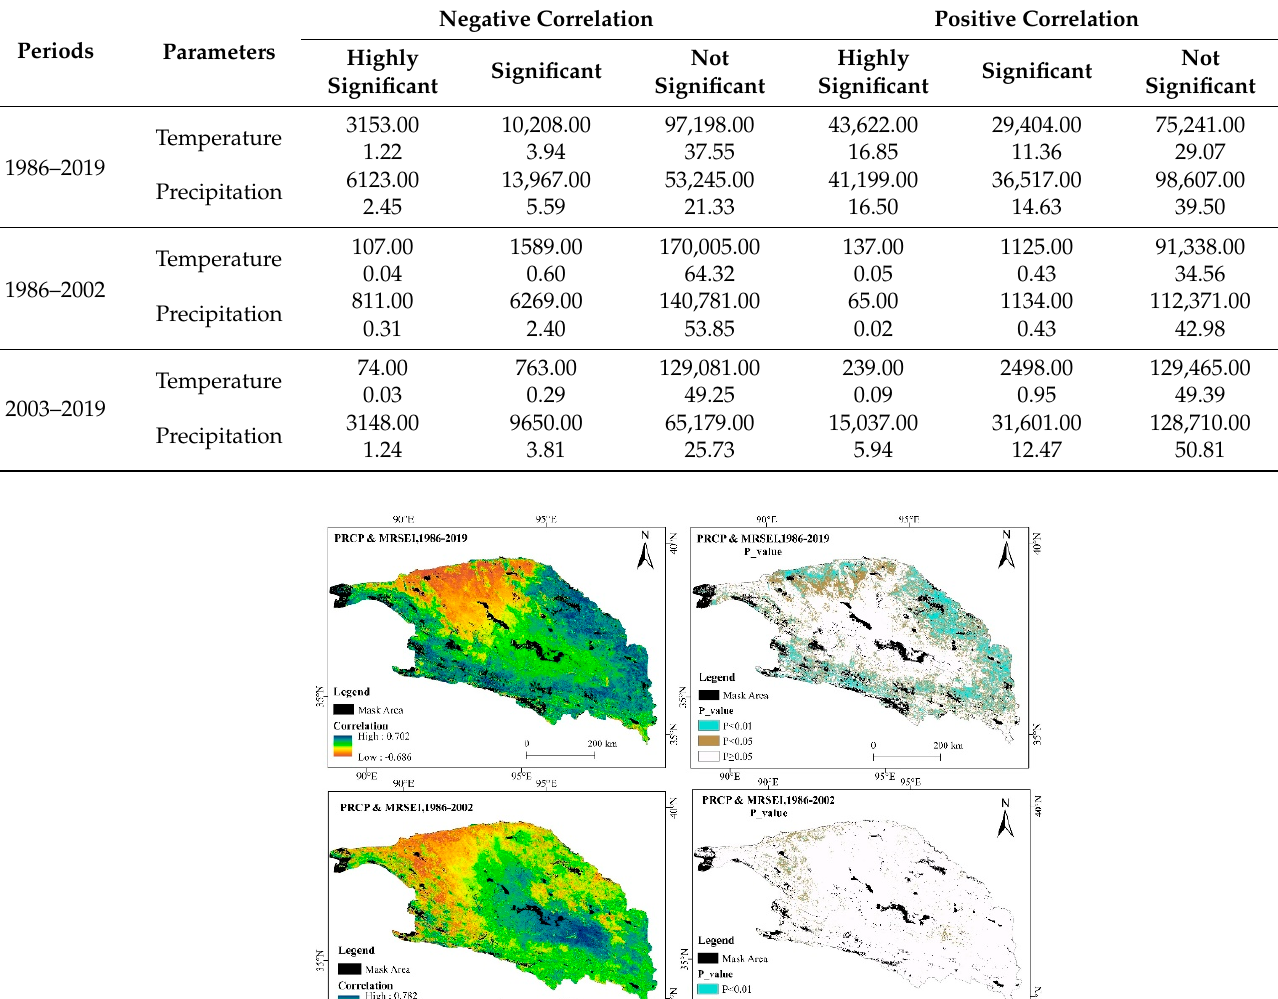
Table 7. The correlation between MRSEI and climate factors in Qaidam Basin from 1986 to 2019 (km 2 , %).